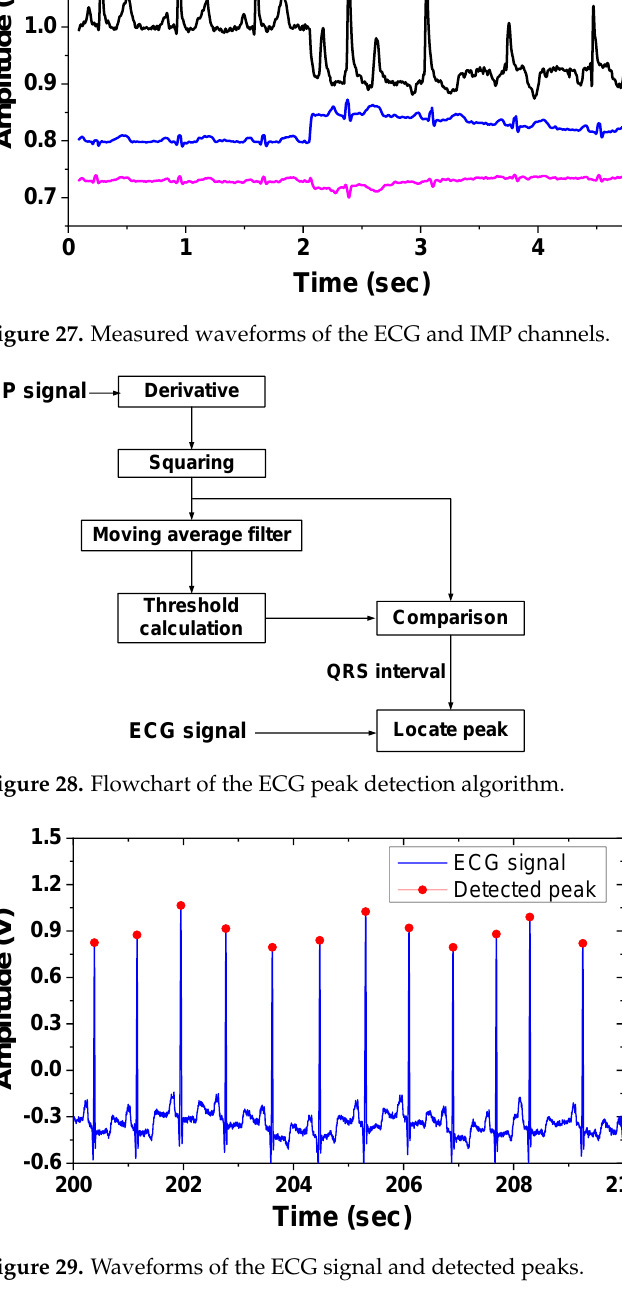
Figure 29. Waveforms of the ECG signal and detected peaks. Table 1. Power breakdown.